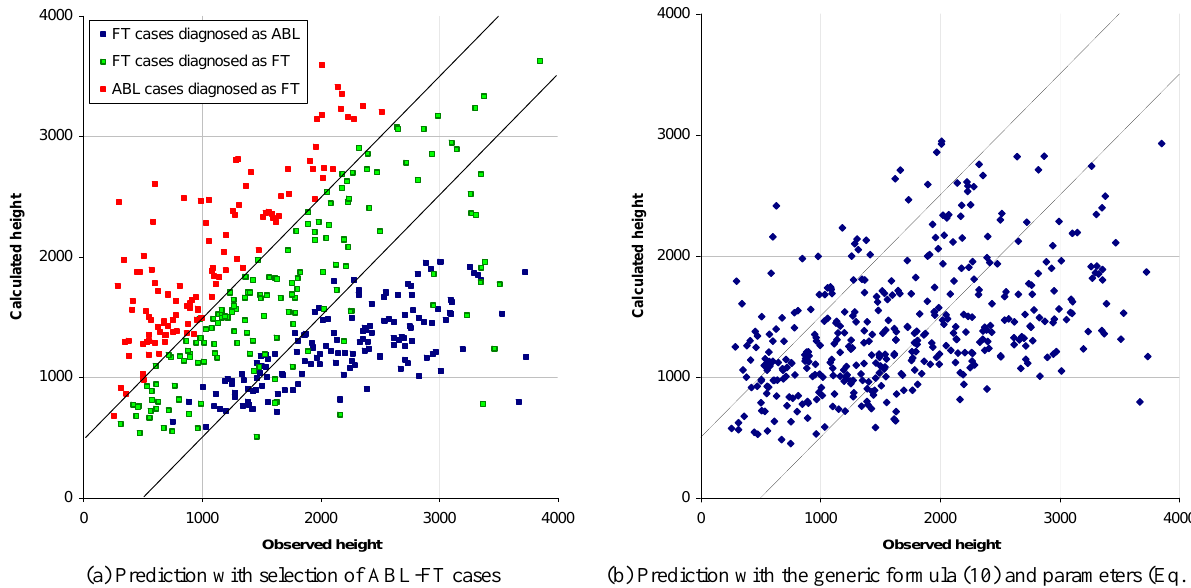
Fig. 6. Performance of the formulas (10, 19) for the cases detected as FT with the selection parameters (Eq. 21) (left-hand panel) and the general fit (Eq. 13) (right-hand panel).